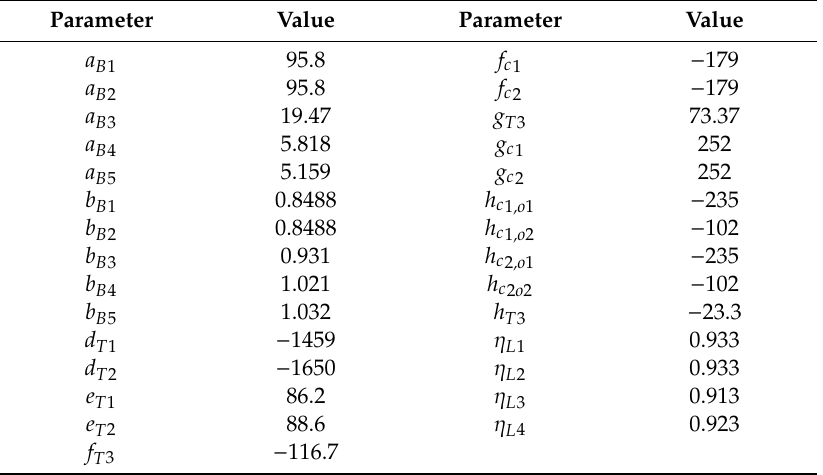
Table 2. Model parameters of boiler and steam turbine (ST).